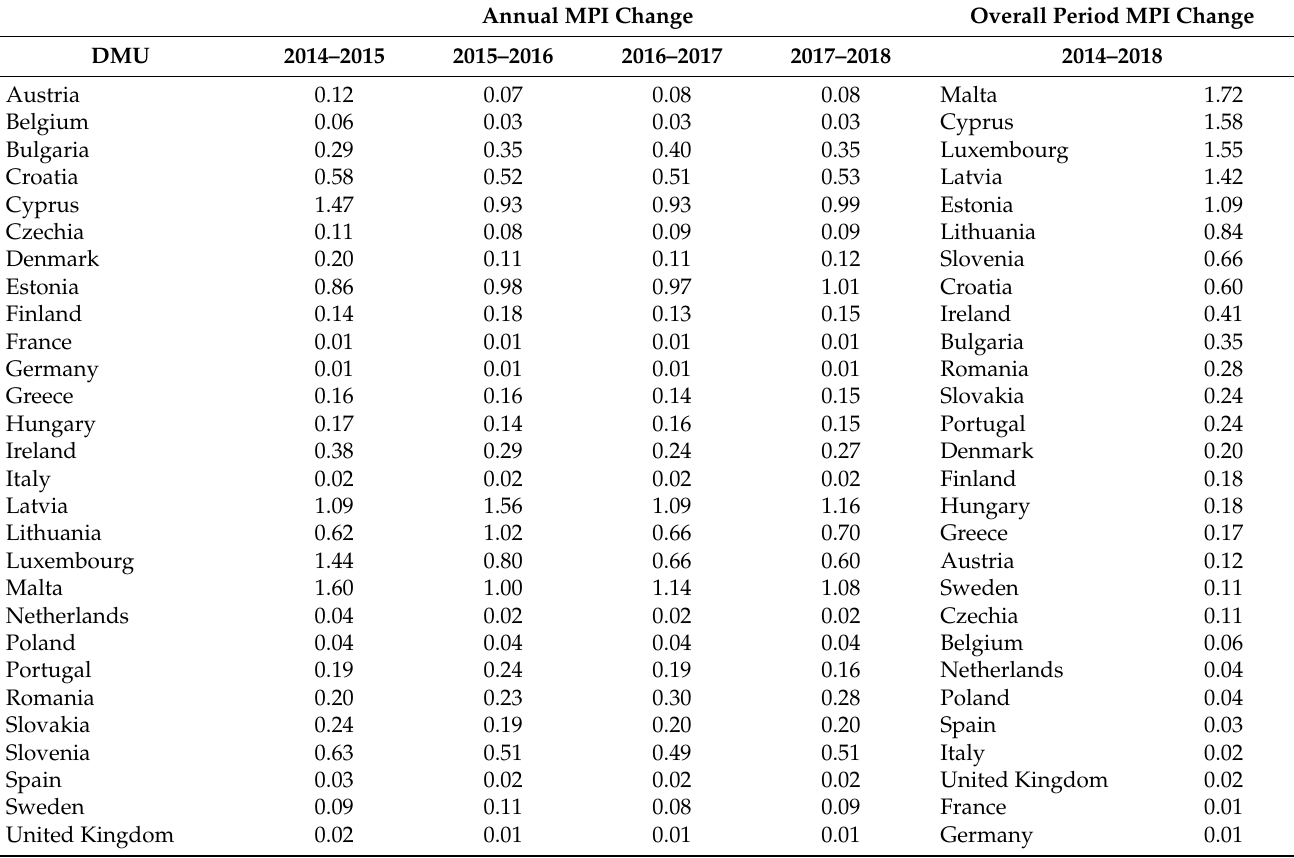
Table 4. Annual and overall MPI results for the reference period